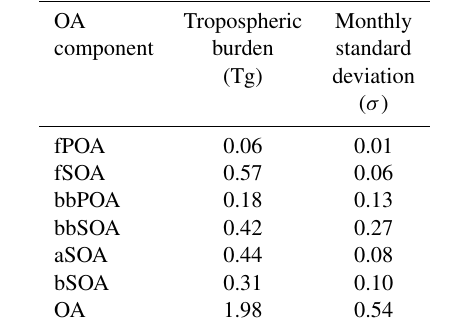
Table 1. Predicted tropospheric burden in Tg of organic aerosol components during the decade